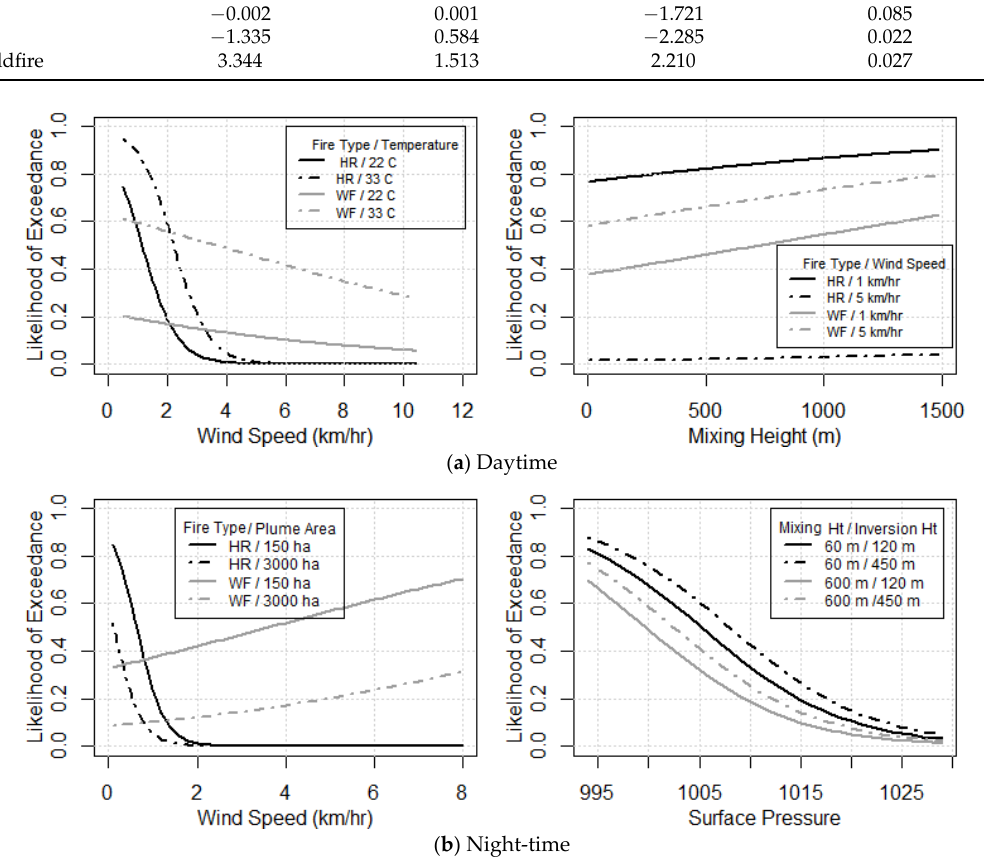
negative effect of wind speed, positive effects of temperature and mixing height, and an for prescribed burns and negligible for wildfires (Table 2, Figure 7a). For a prescribed burn, if the air is still (wind speed < 1 km/h), then an exceedance is almost certain, but the likelihood falls to near zero once wind speed exceeds 4 km/h. For wildfires, the likelihood of exceedance is lower and decreases more gradually with increasing wind speed. For